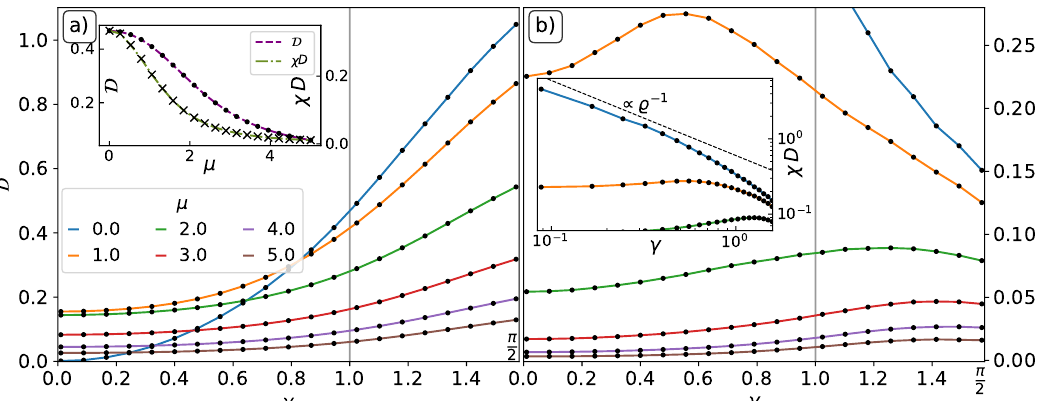
Figure 7: (a) Spin Drude weight D and (b) and diffusion constant D in the discrete Landau–Lifshitz model, cf. Eq. (4), in the easy plane-regime, depending on chemical potential µ and anisotropy γ . (a, inset) Drude weight (purple) and diffusion constant (olive green) as functions of µ at γ = 1 (vertical grey line). (b, inset) Divergence of D at zero average magnetization, µ = 0 (blue curve), in the isotropic limit γ → 0, compared to ∼ 1 /(cid:37) power-law scaling (black dashed line). Simulation parameters: τ = 1 , L = 2 12 , averaged over 10 5 initial